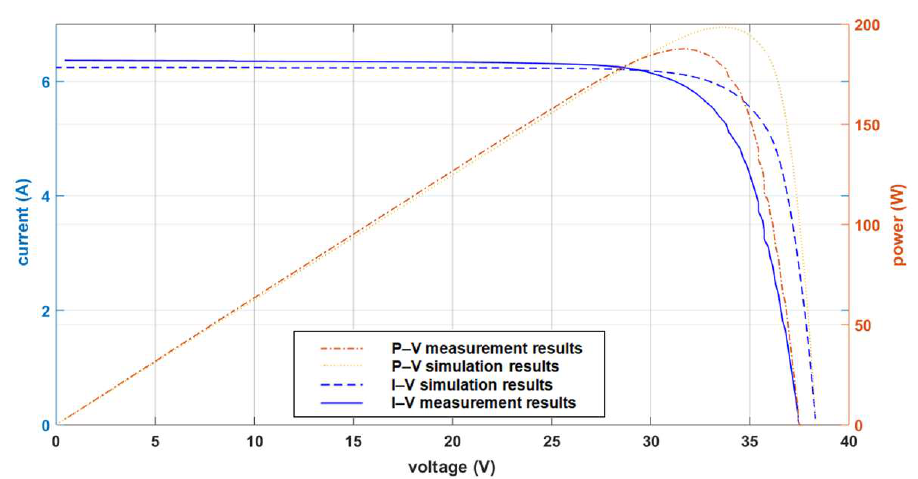
Figure 7. Verification results for measuring point P4 (see Table 2).